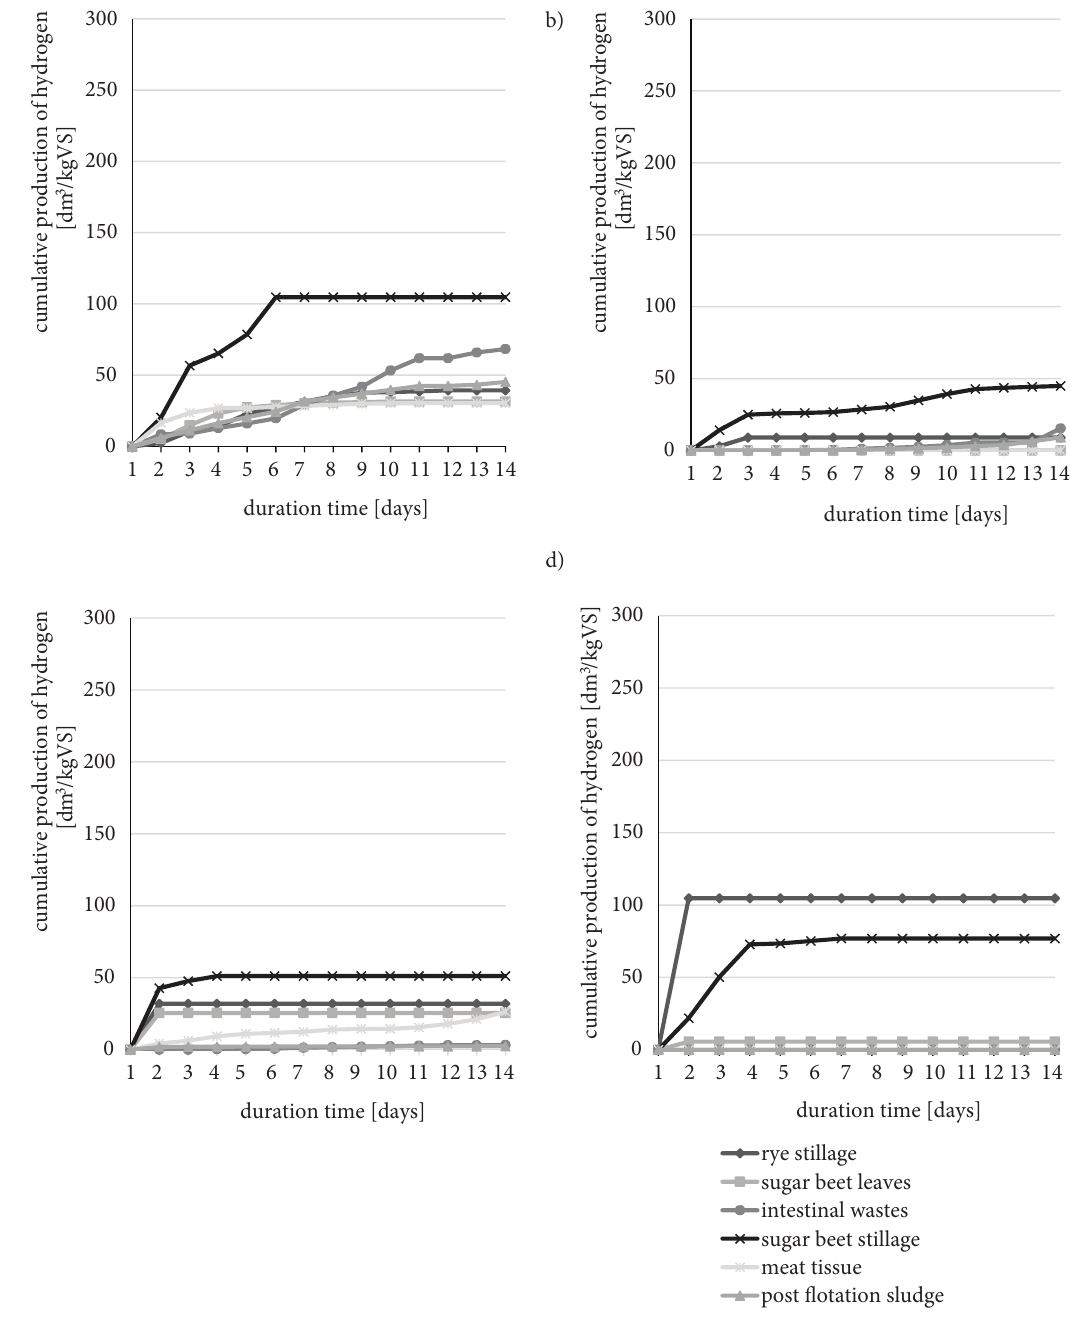
Figure 3. Cumulative hydrogen production a) – without correction, b) – with pH adjustment, c) – with thermal correction, d) – with pH adjustment and thermal correction in batch experiments from RS, SBL, SBS and